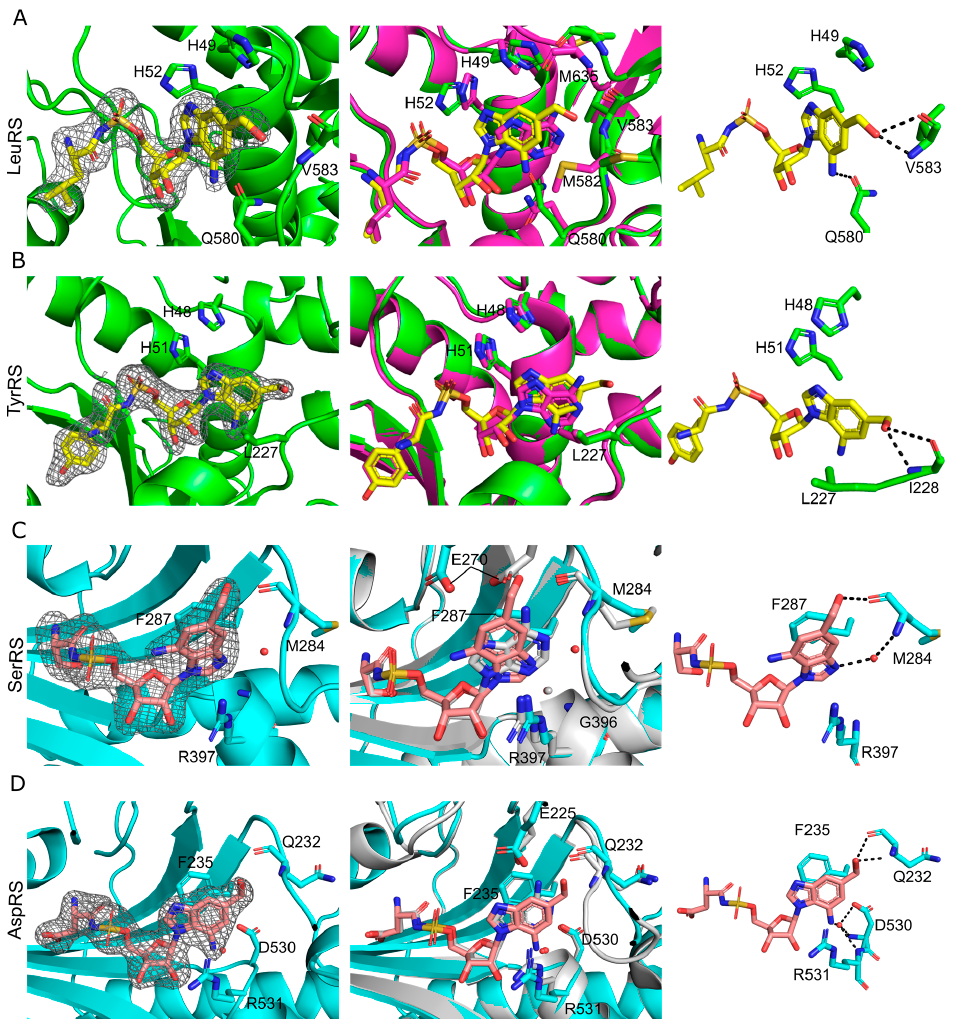
Figure 5. X-ray structures of aaS7HMDDA bound to the corresponding aaRS of class I (green) and class II (cyan). ( A ) N. gonorrhoeae LeuRS in complex with LeuS7HMDDA; ( B ) E. coli TyrRS in complex with TyrS7HMDDA; ( C ) K. pneumoniae SerRS in complex with SerS7HMDDA; ( D ) T. thermophilus AspRS in complex with AspS7HMDDA. Left: electron density map for the ligand; Middle: superposition of aaS7HMDDA and aaSA bound structures; Right: protein–aaS7HMDDA interactions. Protein structures are presented as cartoon representations. The ligand and interacting residues are shown in stick representations. A conserved structured water molecule in SerRS and AspRS is shown as a sphere.